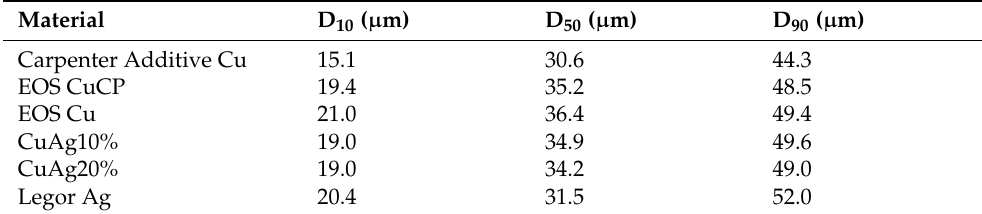
Table 3. High-purity Cu and Ag powder particle volume